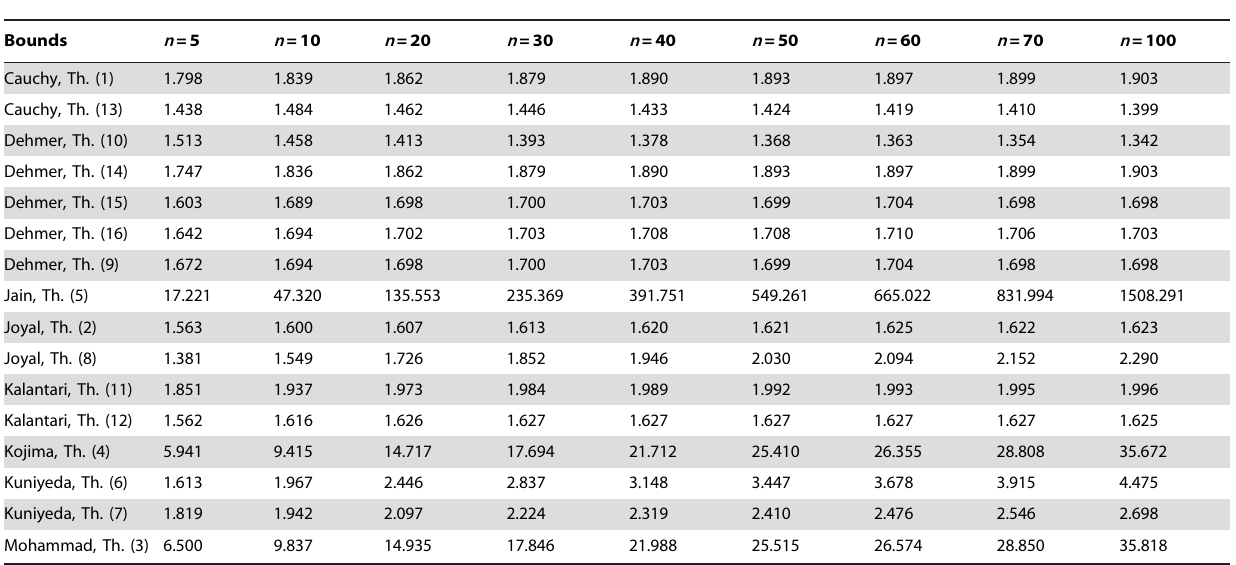
Table 3. Mean bounds values for polynomials P i [ C 3